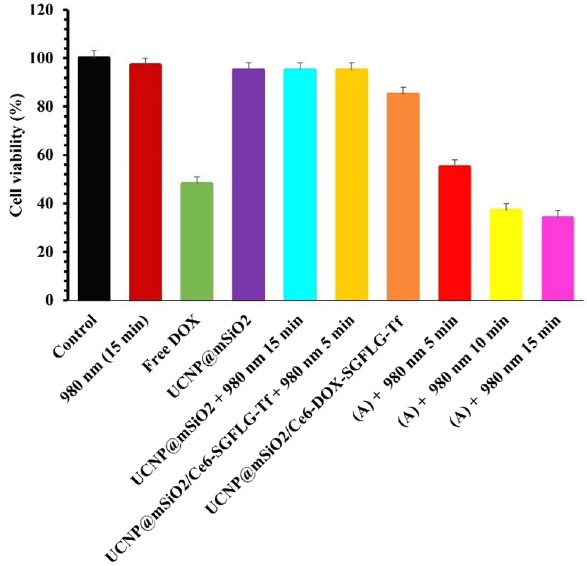
Figure 38: Cell viability of HeLa cells under pure NIR, or incubated with free Dox (equal Dox concentration with NPs), UCNP@mSiO2, UCNP@mSiO 2 /Ce6-SGFLG-Tf, and UCNP@mSiO2/Ce6-Dox- SGFLG-Tf without and with 5, 10 or 15 min NIR irradiation (980 nm, 0.5 W cm − 2 ).